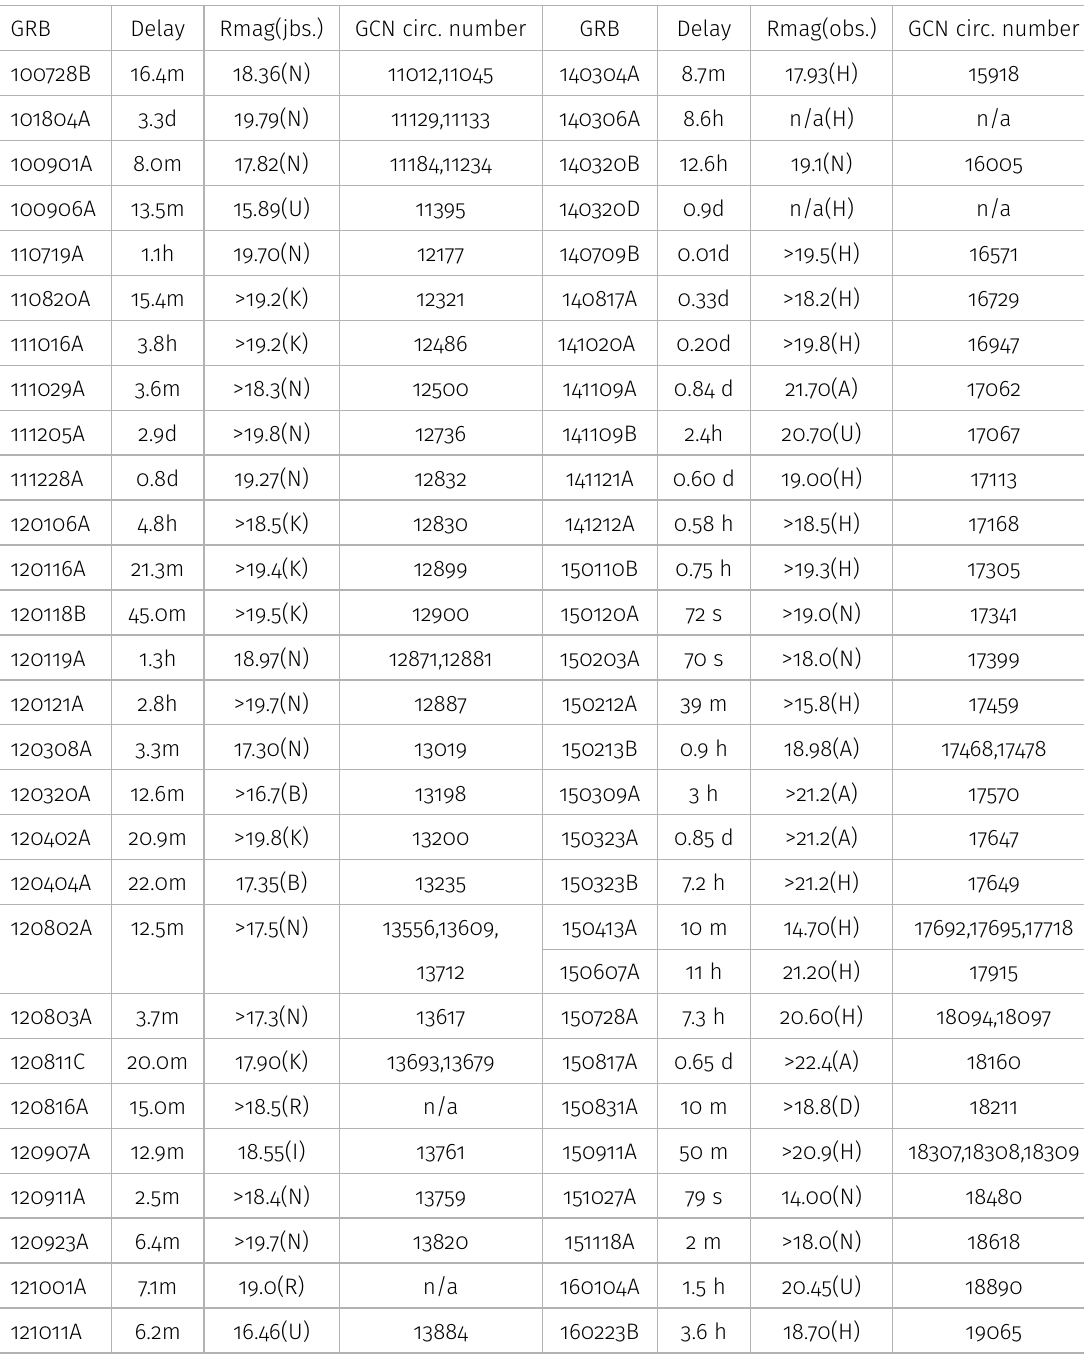
Table II. GRBs observed with small aperture telescopes of IKI GRB-FuN network. In the column (1) we report a name of GRB, in the column (2) the time delay between GRB trigger time and start of observation is presented. In the column (3) we provide brightness of the OT at the first detection (or 3 σ upper limit) with the observatory identified in parentheses (for the identifier see Table I). The last column gives a reference to a GCN circular where result was published. Most of observations are unfiltered. Brightness is estimated against USNO-B1.0 reference stars, R